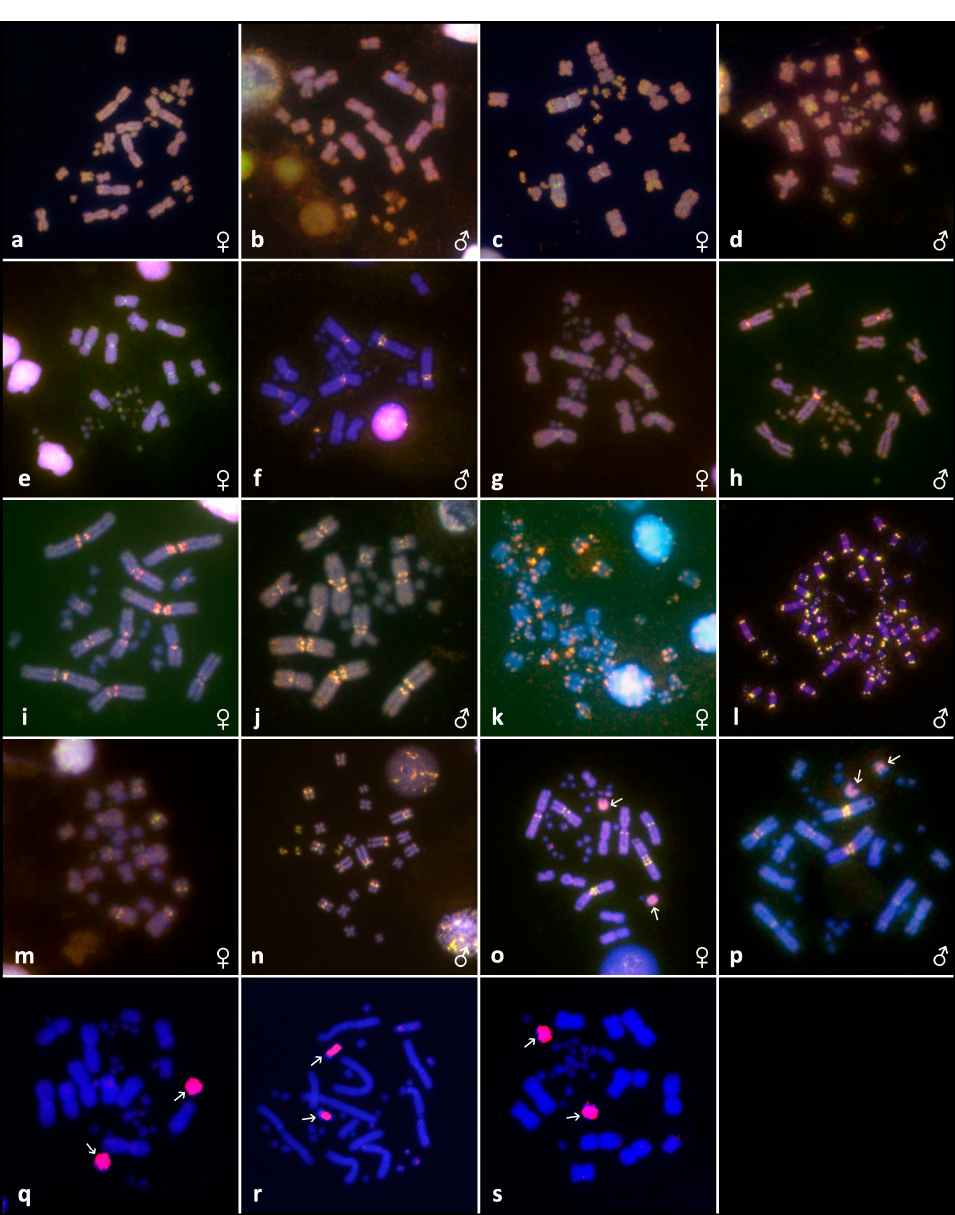
Figure 4. Results of comparative genomic hybridization (CGH) and chromosome painting. Results of CGH in female and male metaphases of Calumma brevicorne ( a , b ), Calumma cf. crypticum ( c , d ), Calumma globifer ( e , f ), Calumma parsonii ( g , h ), Chamaeleo calyptratus ( i , j ), Rieppeleon brevicaudatus ( k , l ), Trioceros hoehnelii ( m , n ) and Trioceros johnstoni ( o , p ). The male DNA is stained with fluorescein isothiocyanate (FITC; green colour), the female DNA with rhodamine (red colour). Regions common for genomes of both sexes are yellow (combination of green and red). Results of chromosome painting with microdissected chromosomes in Trioceros johnstoni ( q – s ). Chromosomes microdissected from pair 7 in female labelled with rhodamine hybridised separately in female metaphases ( q , r ). The probe prepared from male pair 7 also hybridized to both chromosomes of pair 7 in female metaphases ( s ). Trioceros bitaeniatus : the karyotype consists of 2n = 24 of which 20 are macrochromosomes and 4 microchromosomes as described previously [40]. All macrochromosomes are biarmed (Figure 3i). C- banding uncovered heterochromatin in the centromeres/pericentromeric regions (Figure 3j). ITSs were detected in pairs 1 and 2 (Figure 3k). In pair 2 we observed a secondary constriction at the site where the rRNA probe was bound (Figure 3l).